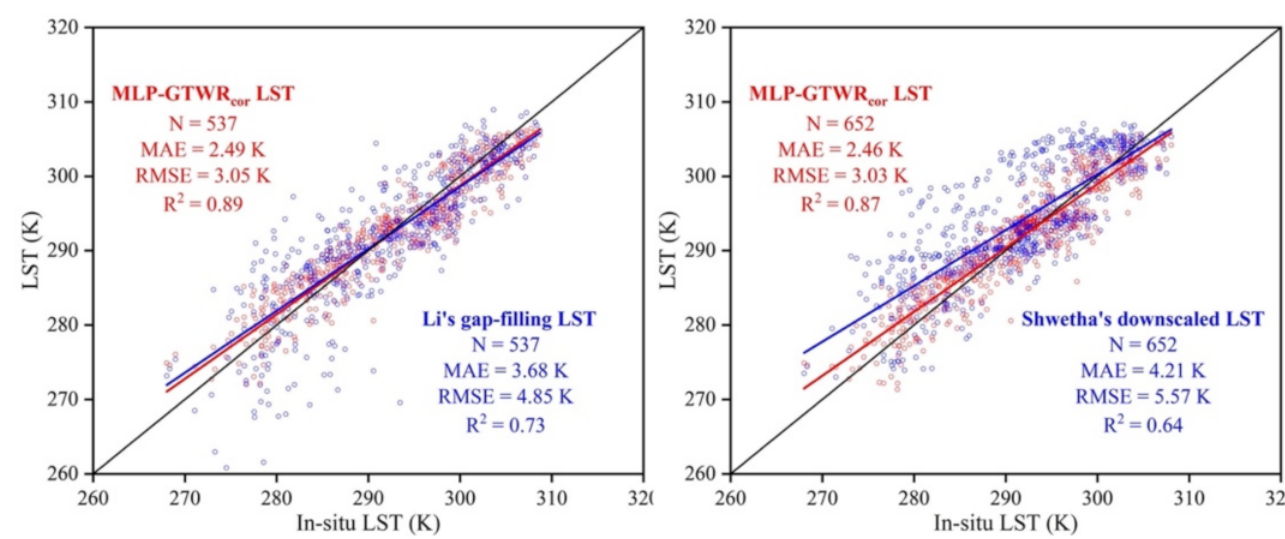
Figure 11. Comparison of the MLP-GTWR LST cor and two reconstructed LST using the method in Li et al. (2018) and Shwetha and Kumar (2016) against the in situ